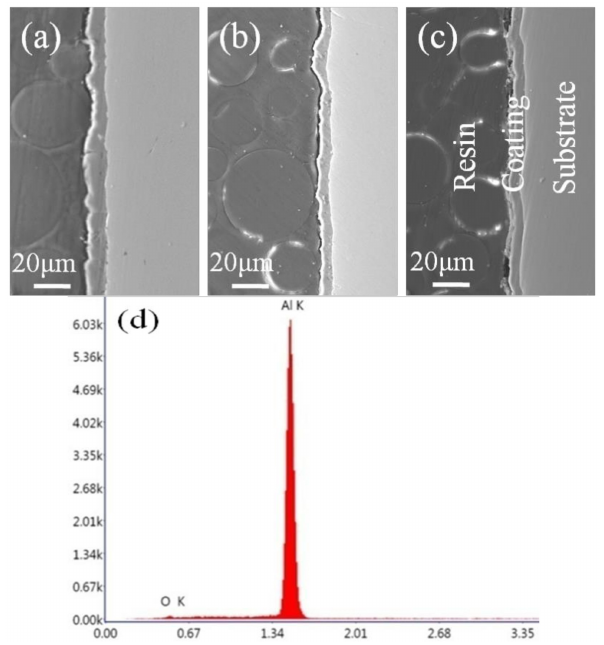
Figure 3. Cross-section features of Al coatings formed on ( a ) 1Cr8, ( b ) 1Cr13, and ( c ) 1Cr15 steel substrates and ( d ) the corresponding energy dispersive spectroscopy (EDS) spectrum after 1 h of IL